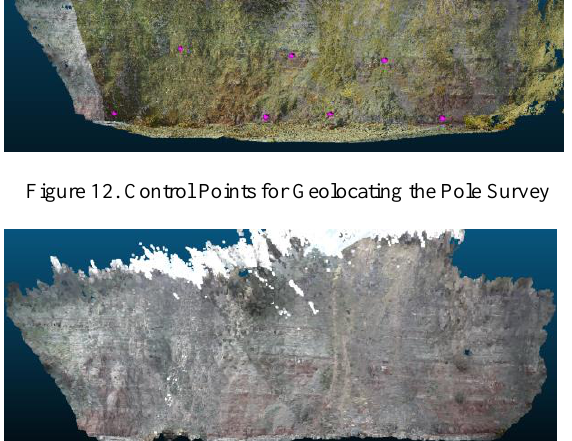
Figure 16. PSPC and TLSPC Contours generated in Suffer Golden Software